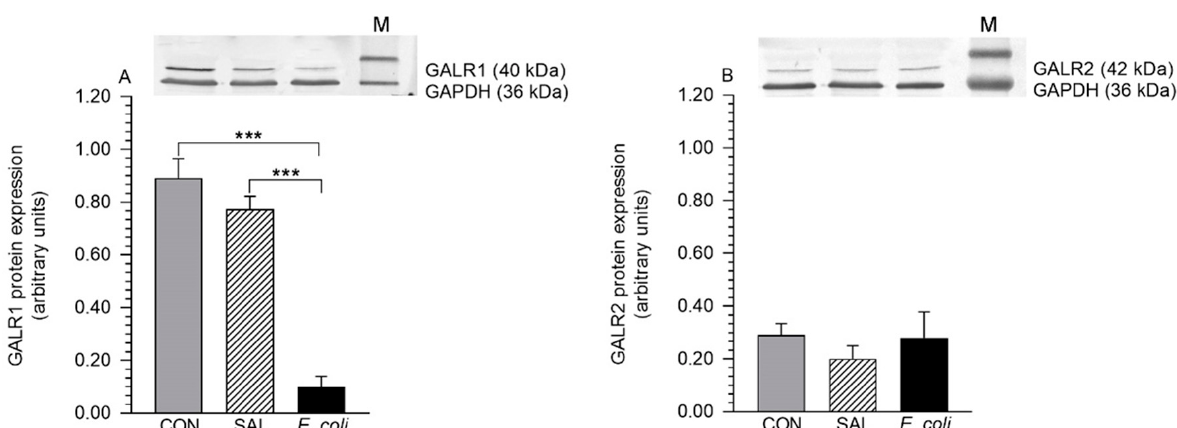
Figure 1. The protein expression of GALR1 ( A ) and GALR2 ( B ) in the myometrial layer of gilts from the control (CON), saline (SAL), and E. coli groups, estimated by Western blot analysis. Representative blots are shown in the top panels. Protein levels of studied receptors are expressed as the mean ± SEM of ratios of glyceraldehyde-3-phosphate dehydrogenase (GAPDH). *** p < 0.001 compared between groups for the same type of receptor. M—marker.